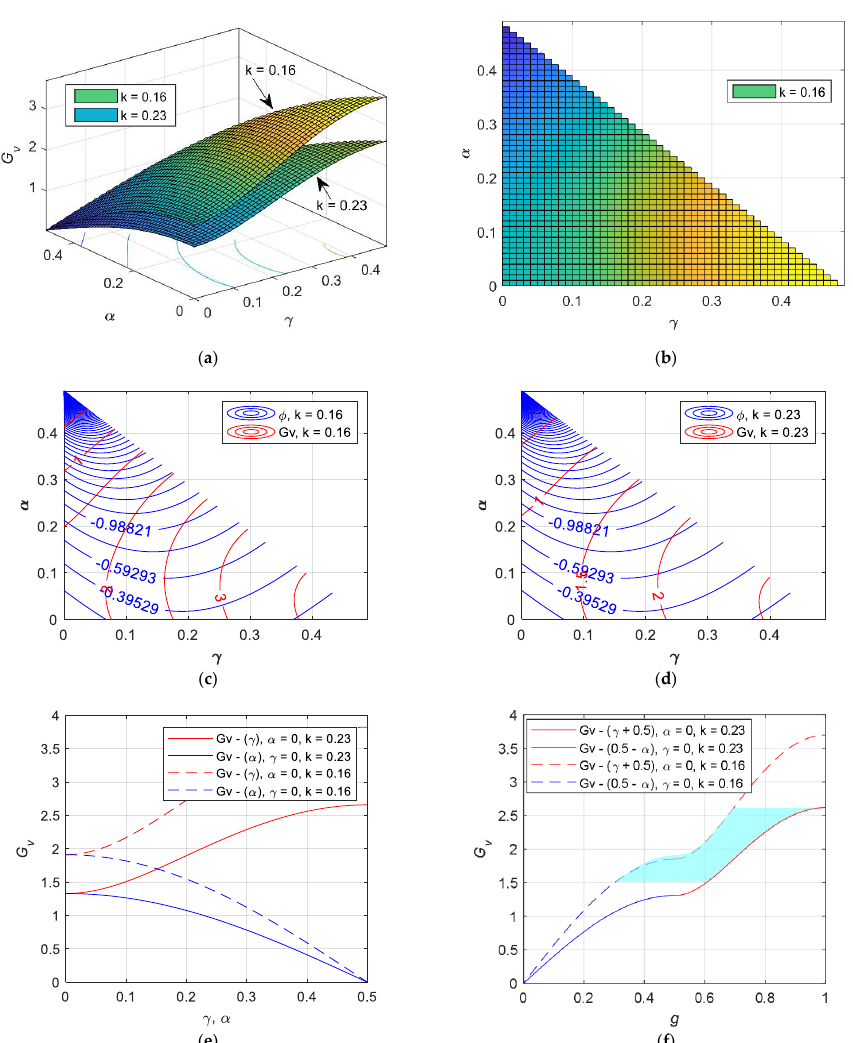
Figure 5. The voltage gain of TL rectifier: ( a ) a 3D plot of voltage gain for k = 0.23 and 0.16; ( b ) a 2D plot of voltage gain for k = 0.16; ( c ) plot of G V and φ for k = 0.16; ( d ) plot of G V and φ for k = 0.23; ( e ) plot of G V in optimal trajectory; ( f ) plot of G V operating region in optimal trajectory.